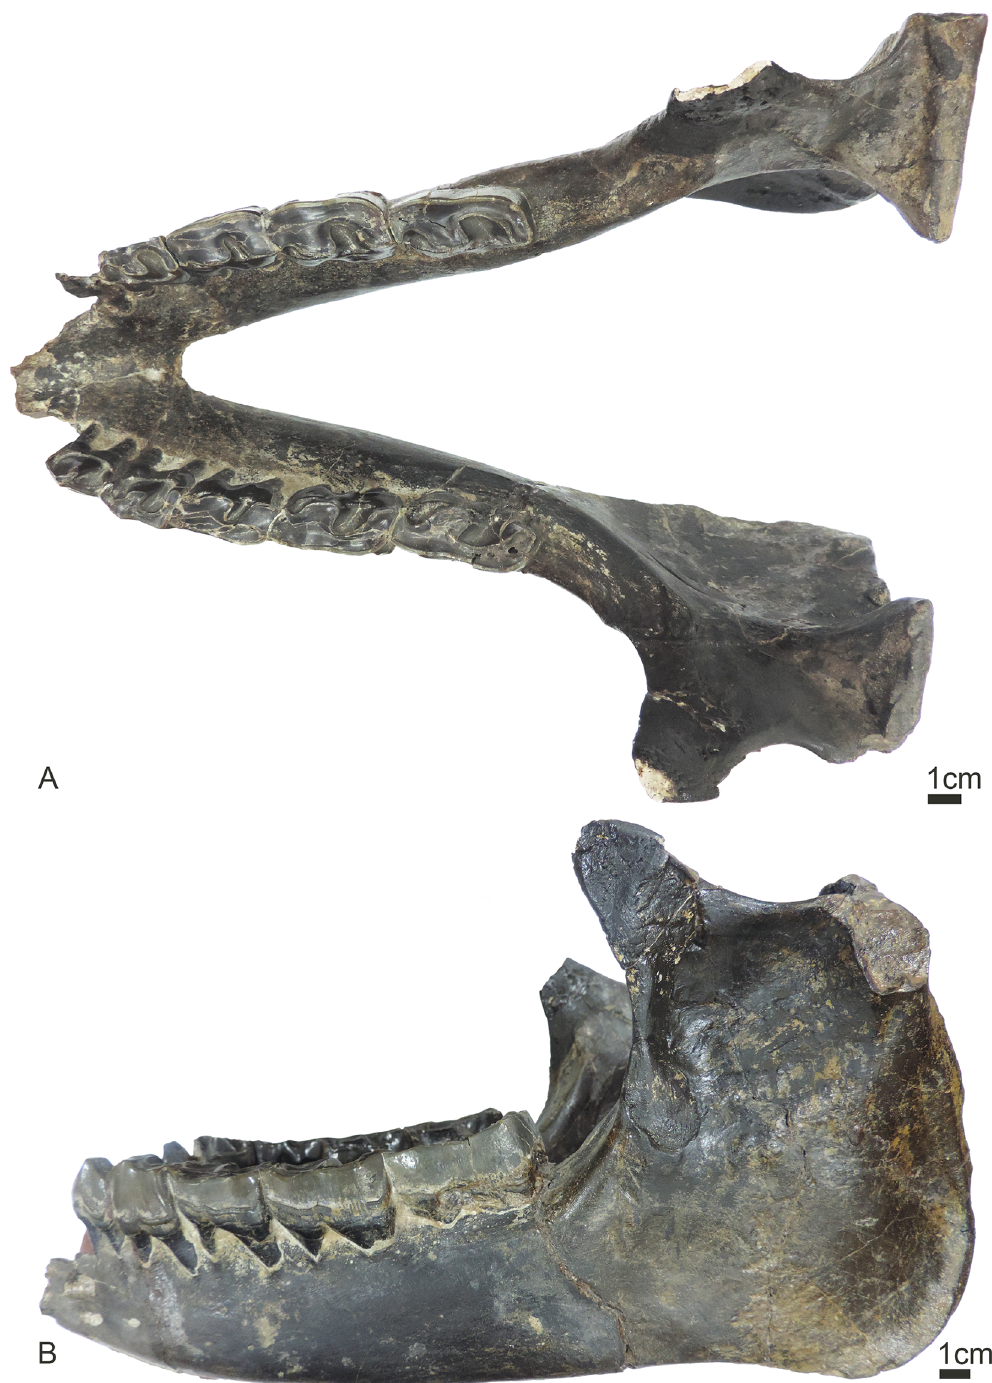
Fig 4. Mandible of Sellamynodon zimborensis (holotype, UBB MPS 15795). Occlusal (A) and lateral (B) views.